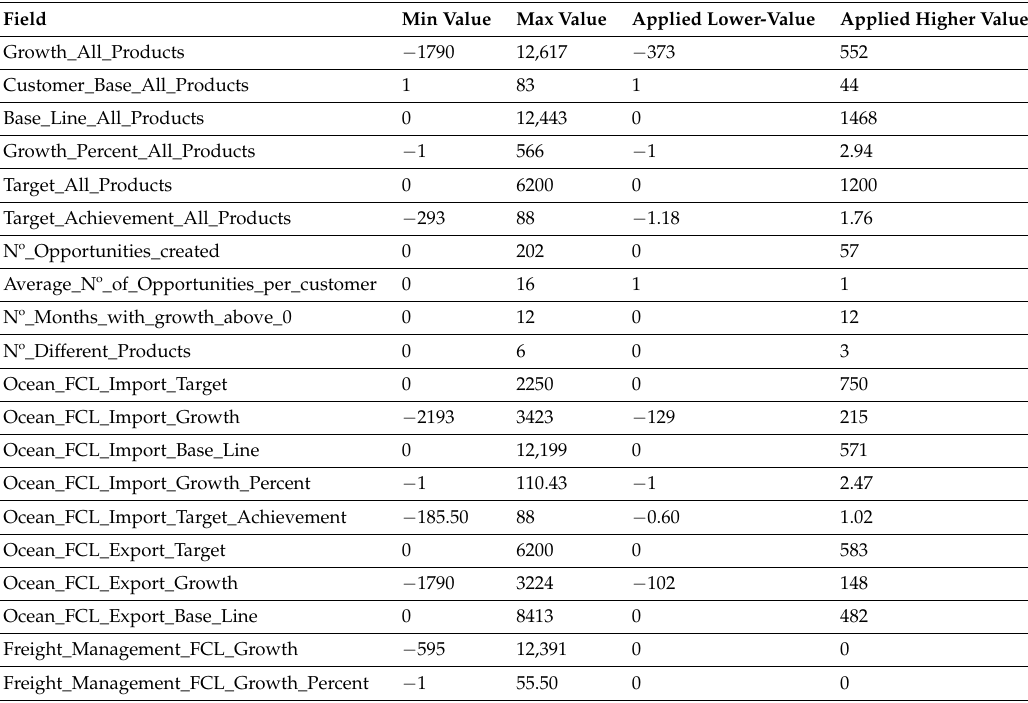
Figure 8. Outlier display. Table 5. Outlier conversion